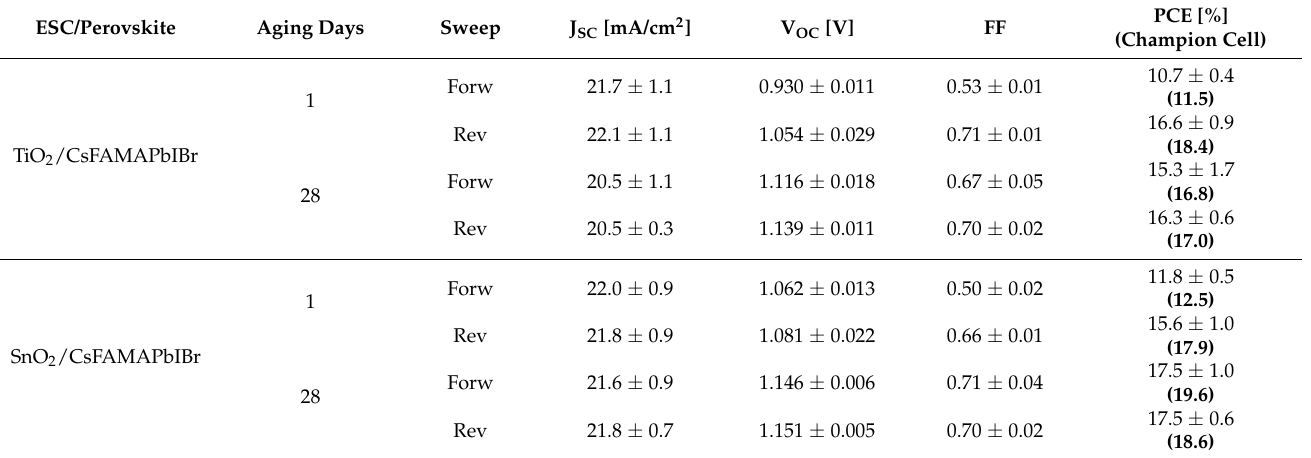
Table 1. Summary of the photovoltaic parameters for CsFAMAPbIBr on either TiO 2 or SnO 2 layers measured in fresh (1 day) and aged (28 days)